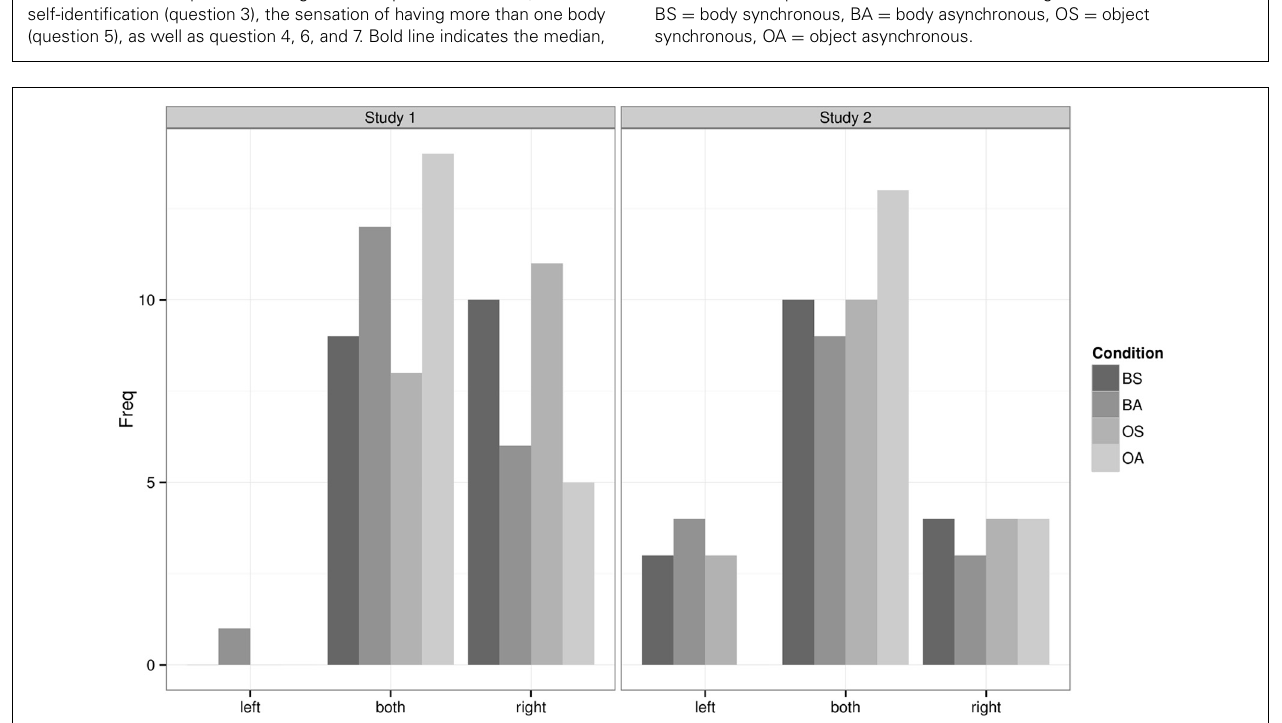
upper and lower limit of the box plot indicate the upper and lower quartile ( = 75th and 25th percentile). Asterisks indicate a significant difference.